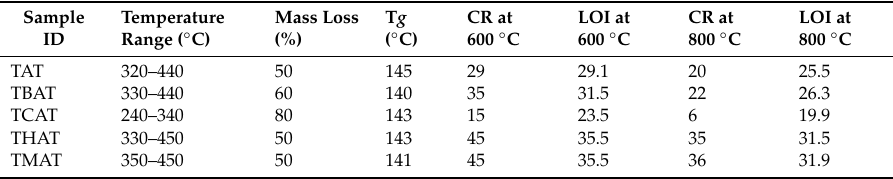
Table 2. Thermal degradation parameters for 3a – e